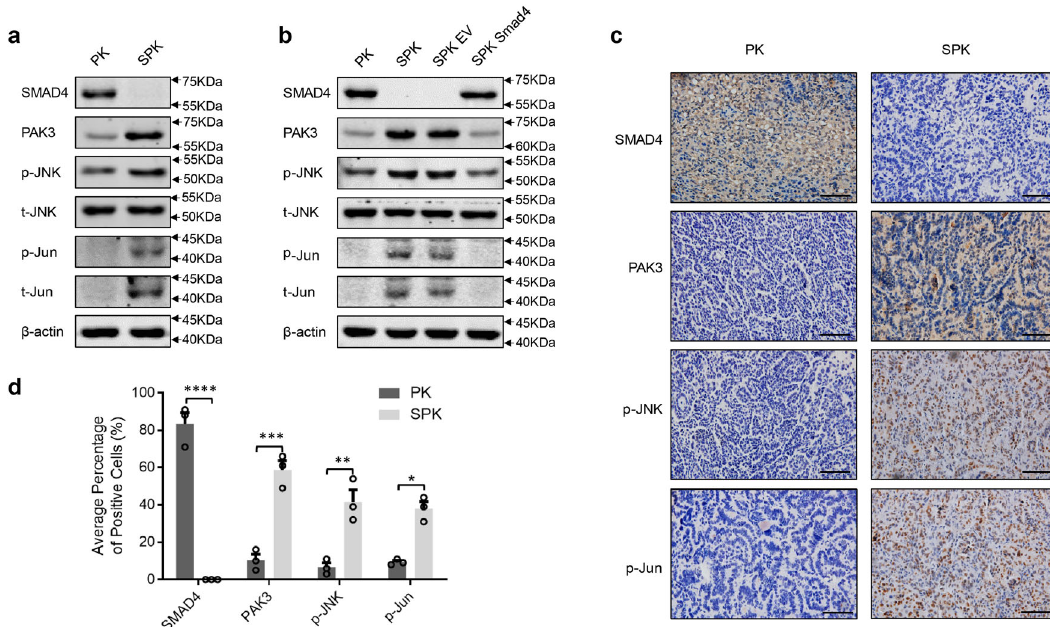
Fig. 4 PAK3 enhances the JNK-Jun signal pathway. a PK and SPK cells were analyzed for the expression of Smad4, PAK3, and JNK-Jun signaling-related factors by Western blotting and the experiment was repeated three times independently with similar results. b Western blots showing the effects of Smad4 overexpression in SPK cells and the experiment was repeated three times independently with similar results. c IHC staining detected the expression of Smad4, PAK3, p-JNK, and p-Jun in mouse lung tumors of PK and SPK mice. Scale bar, 25 μ m (magni fi cation, ×40). d Quanti fi cation of the average percentage of Smad4, PAK3, p-JNK, and p-Jun positive cells in mouse lung tumors of PK and SPK mice. Data presented are the mean ± SEM from three biologically independent samples ( n = 3); * p = 0.001802131; ** p = 0.007103699; *** p = 0.001259358; **** p = 0.000180321; as determined by two-tailed Student ’ s t-